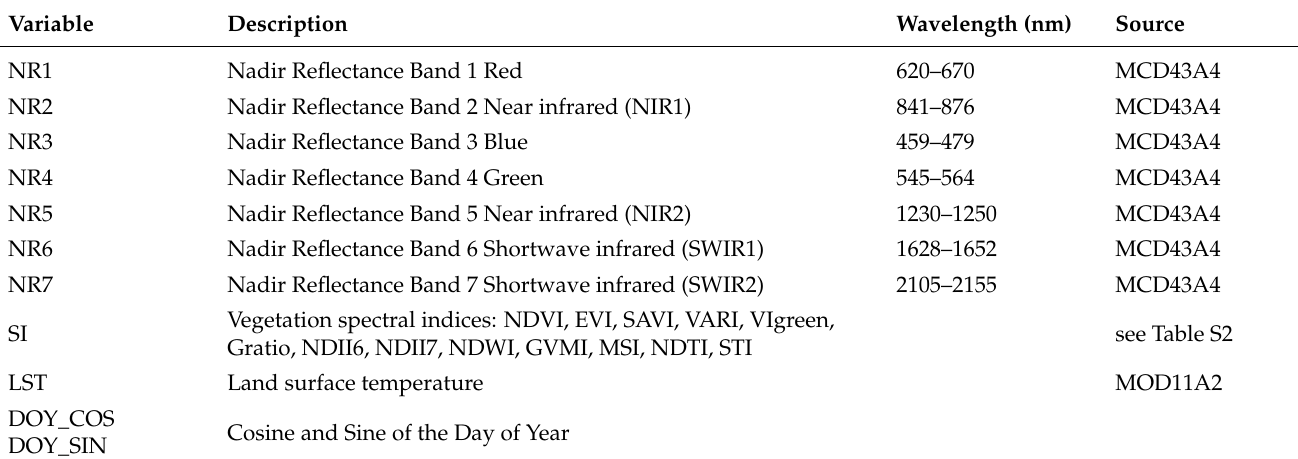
Table 1. List of potential predictors of